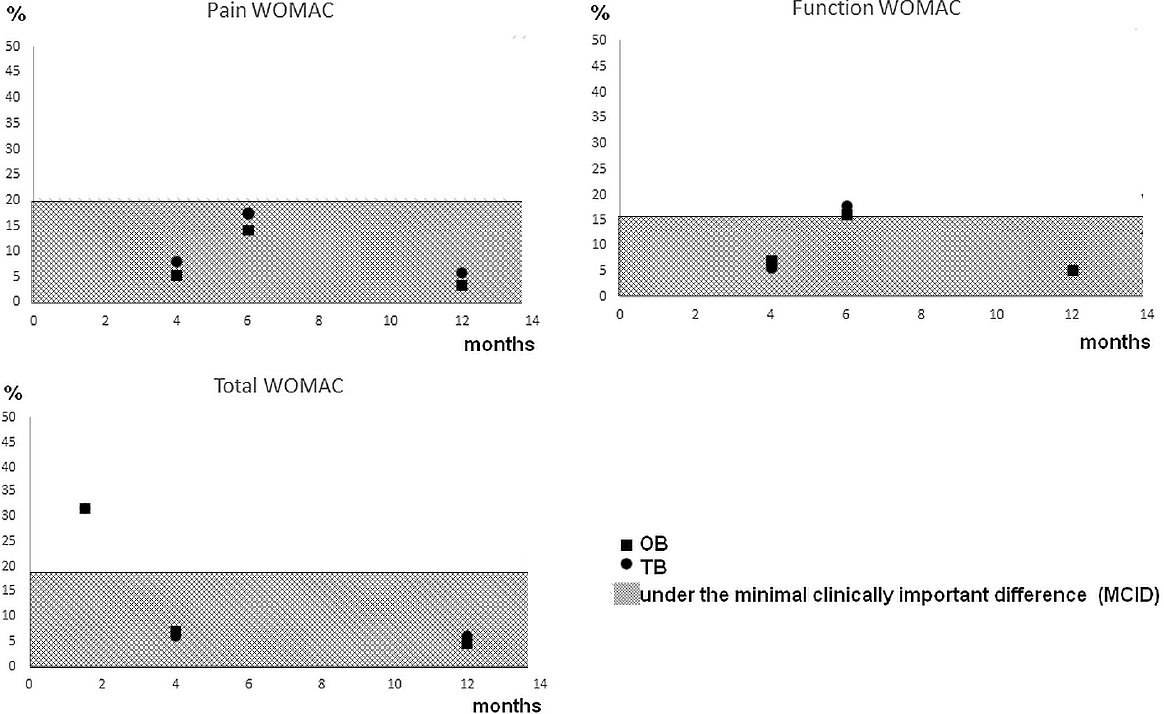
Figure 2. Percentage of changes for each WOMAC score evaluated and the associated